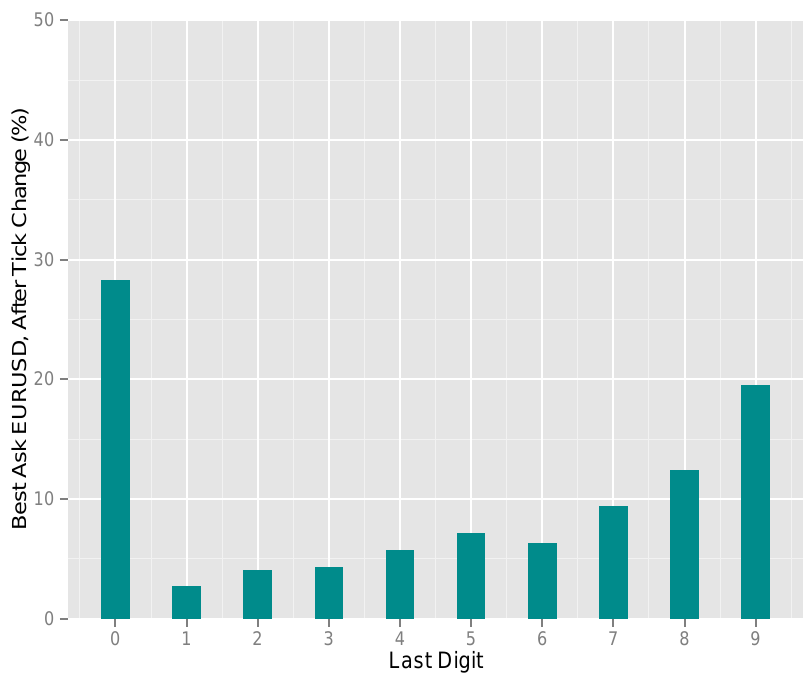
Figure 18. Best Ask Last Digits, After Tick Change. By considering the order sizes at the best bid and ask, it can be further inferred that 70% of the best quotes at newly decimalized levels the can be attributed to high-frequency traders. Table 2 shows the average order size at the best bid and the last digits of the best bid, before and after decimalization. Before decimalization, the average order size is uniformly distributed with respect to last digits. After decimalization, average order size at prices with the last digit zero, i.e., at pre-decimalized levels, is twice as large as those at the newly available decimal levels. In fact, orders placed at the newly